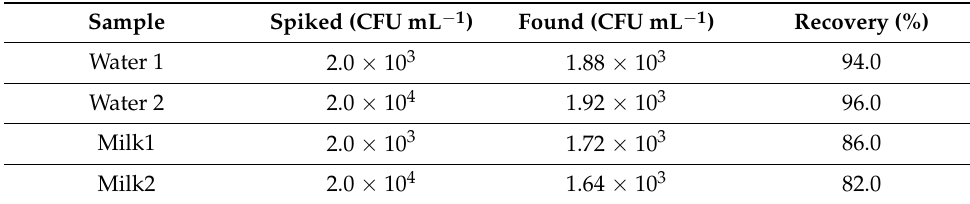
Figure 8. Stability of the PAC-PANI/SPE biosensor over 40days in refrigerated storage at 4 °C. To evaluate the practical feasibility of our electrochemical assay, ExPEC was detected in commercial city water and milk samples. The samples were diluted by PBS and were spiked with ExPEC by the standard addition method with final concentrations of 2.0 × 10 3 and 2.0 × 10 4 CFU/mL. As can be seen from Table 3, the recoveries were 94 and 96% in water and 86 and 82% in milk. The fat, protein, and other substances present in milk samples are attributed to the lower recovery in milk than in water. Table 3. Detection results and recoveries in water and milk samples.